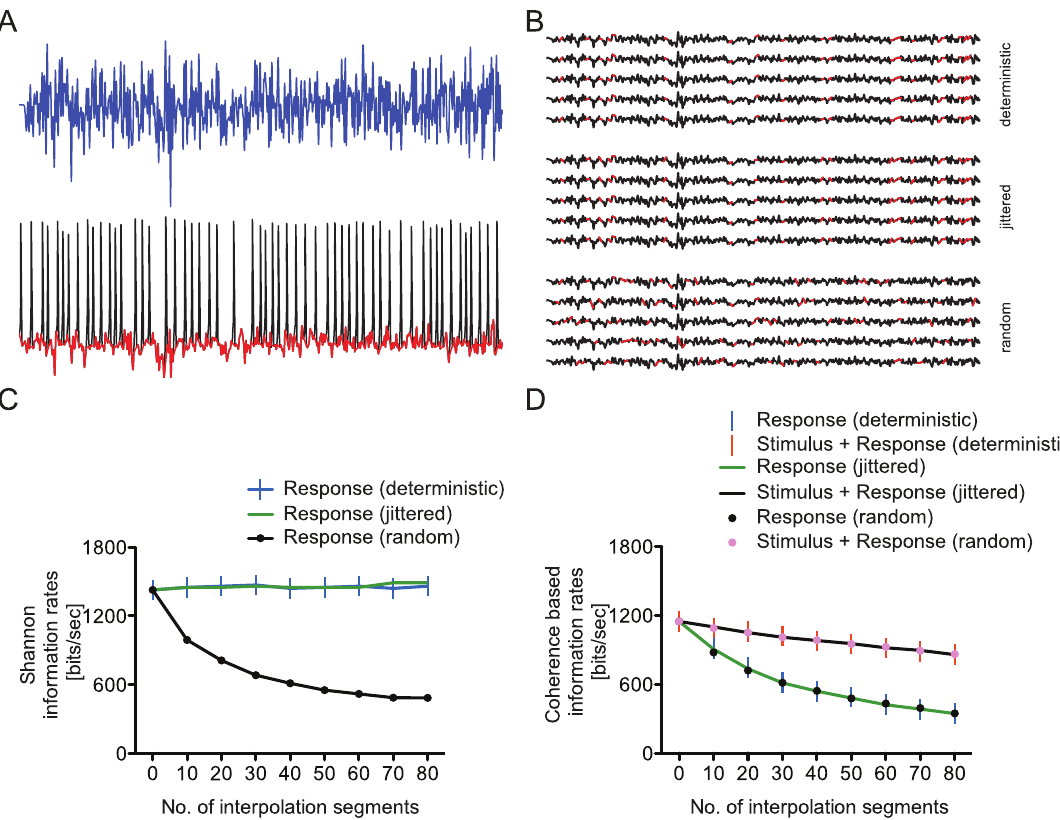
Figure 6. The action potential ‘footprint’ reduces the information encoded in a graded voltage response. A. White noise current (blue) elicits a train of action potentials in the spiking neuron model (black). The same voltage response with the action potentials removed and replaced with a linear interpolation of the voltage (red). B. Sections of the graded voltage response were replaced with a linear interpolation to mimic the ‘footprint’ each action potentials creates when any information contained in the graded response is obscured. The graded responses are shown in black and the interpolated sections in red. The 3 replacement regimes deterministic (upper), jittered (middle) and random (lower) mimicked spiking statistics with different current stimuli (see main text for details). C. The random insertion of 6 ms sections of linear interpolation into graded voltage responses reduces the Shannon information rate. The drop in information rate is greater with more interpolations. Insertion of interpolations in the same (deterministic) or nearly the same (jittered) positions does not affect the Shannon information rate. D. The random insertion of 6 ms sections of linear interpolation into graded voltage responses reduces the coherence-based information rate. The drop in information rate is greater with more interpolations. The insertion of interpolations in the same (deterministic) or nearly the same (jittered) positions have the same effect upon the coherence-based information rate as the random insertion. Insertion of interpolations into the same positions within the stimulus as well as the response reduces the effect upon the coherence-based information